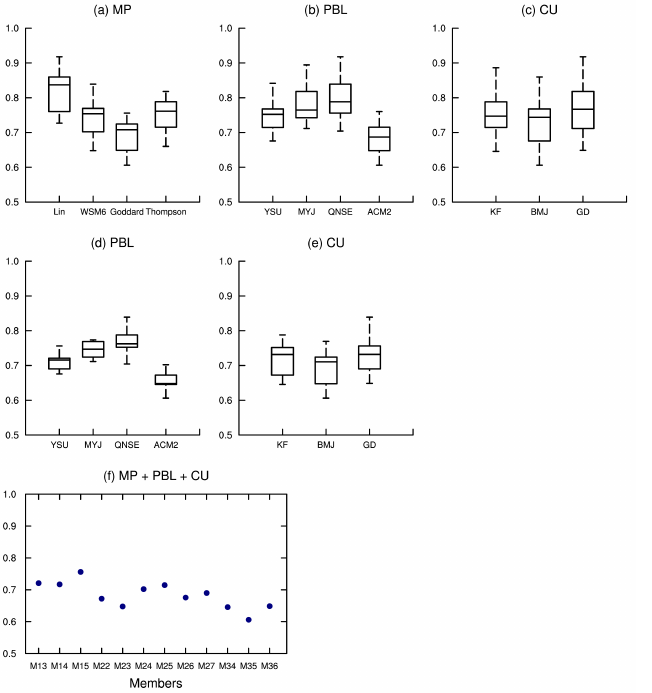
Figure 11. Same as Figure 10, but for the period of 00:00 UTC to 11:00 UTC. The second row retains only those members with WSM6 and Goddard MP schemes, and the third row additionally excludes those members containing MYJ and QNSE PBL schemes.